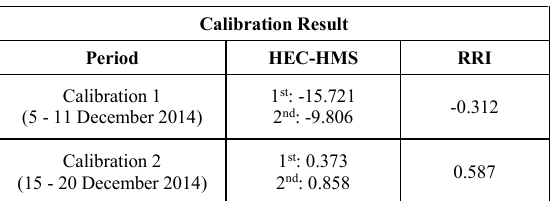
Table 3. Result comparison between HEC-HMS and RRI for